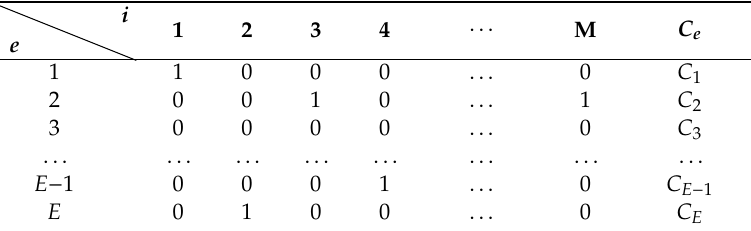
Table 2. Relationship matrix of movement i and corridors e